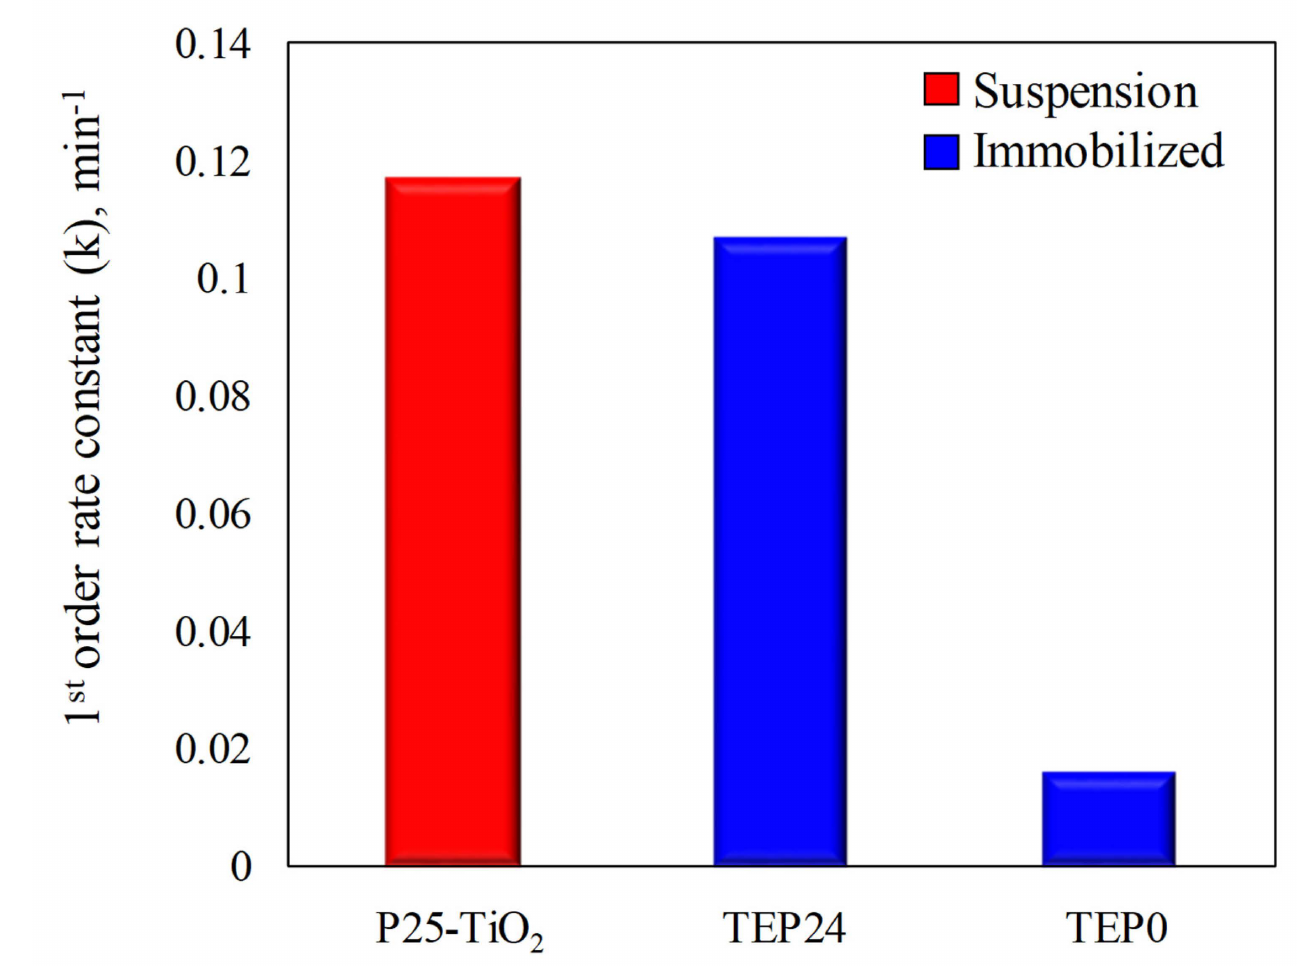
Figure 13. Pseudo first-order rate constant, (min − 1 ) for removal of 30 mg L − 1 RR4 dye via photo- catalysis using P25–TiO 2 suspension system, and immobilized TEP0 and TEP24 catalyst